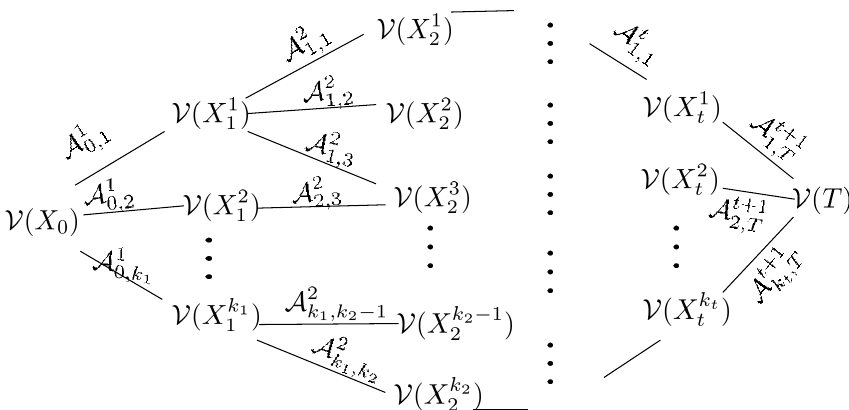
Figure 6. An illustration of the multiple interval dynamic programming approach for motion planning.